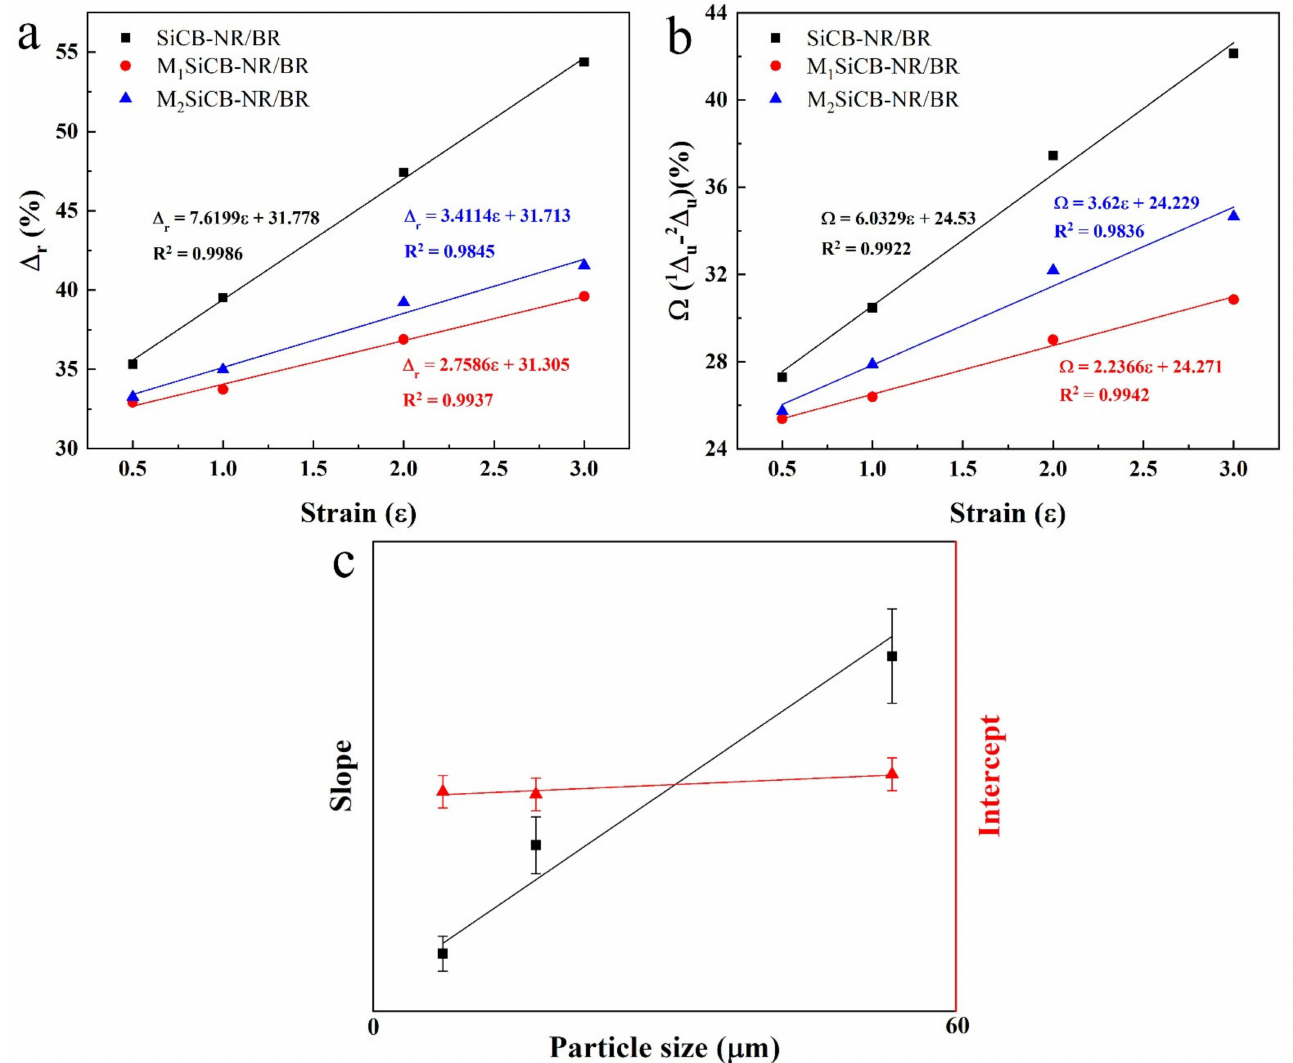
Figure 8. ( a ) The dissipation factor ( ∆ r ), ( b ) the difference of dissipation factor ( Ω ) as a function of ε m for SiCB-NR/BR composites with different fillers particle size, and ( c ) schematic for the effect of filler size on Mullins